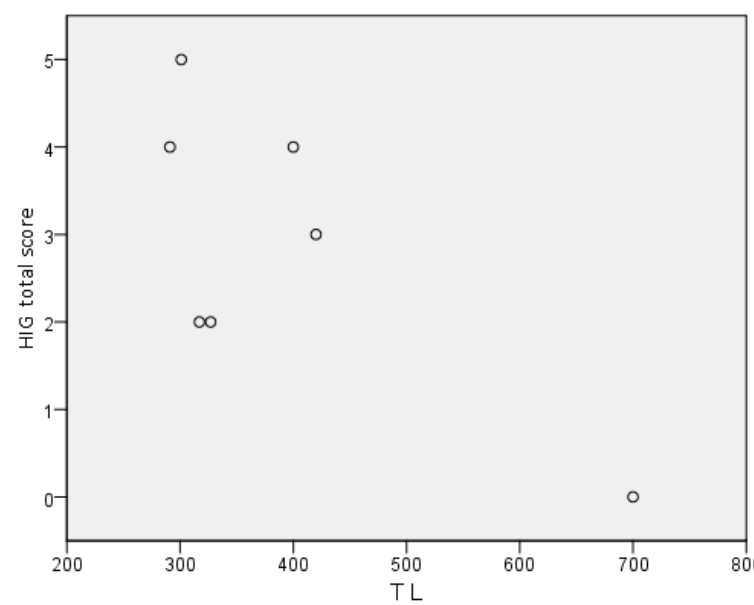
Figure 2. Scatter plot of human polyclonal immunoglobulin G total score (HIG total score) and IgG trough level (TL). Spearman’s correlation coefficient: −0.600, p = 0.154.